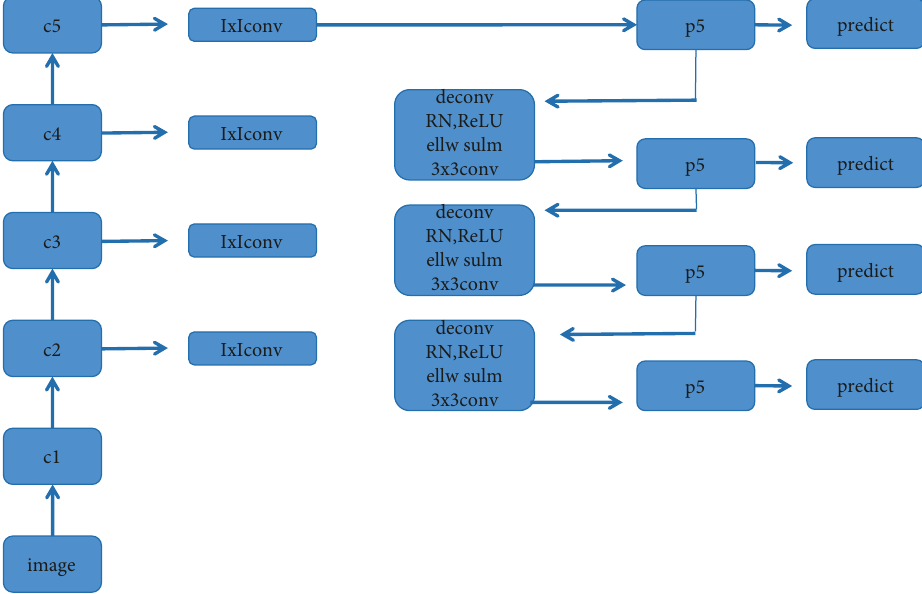
Figure 5: Combination mode of ResNet and FPN.